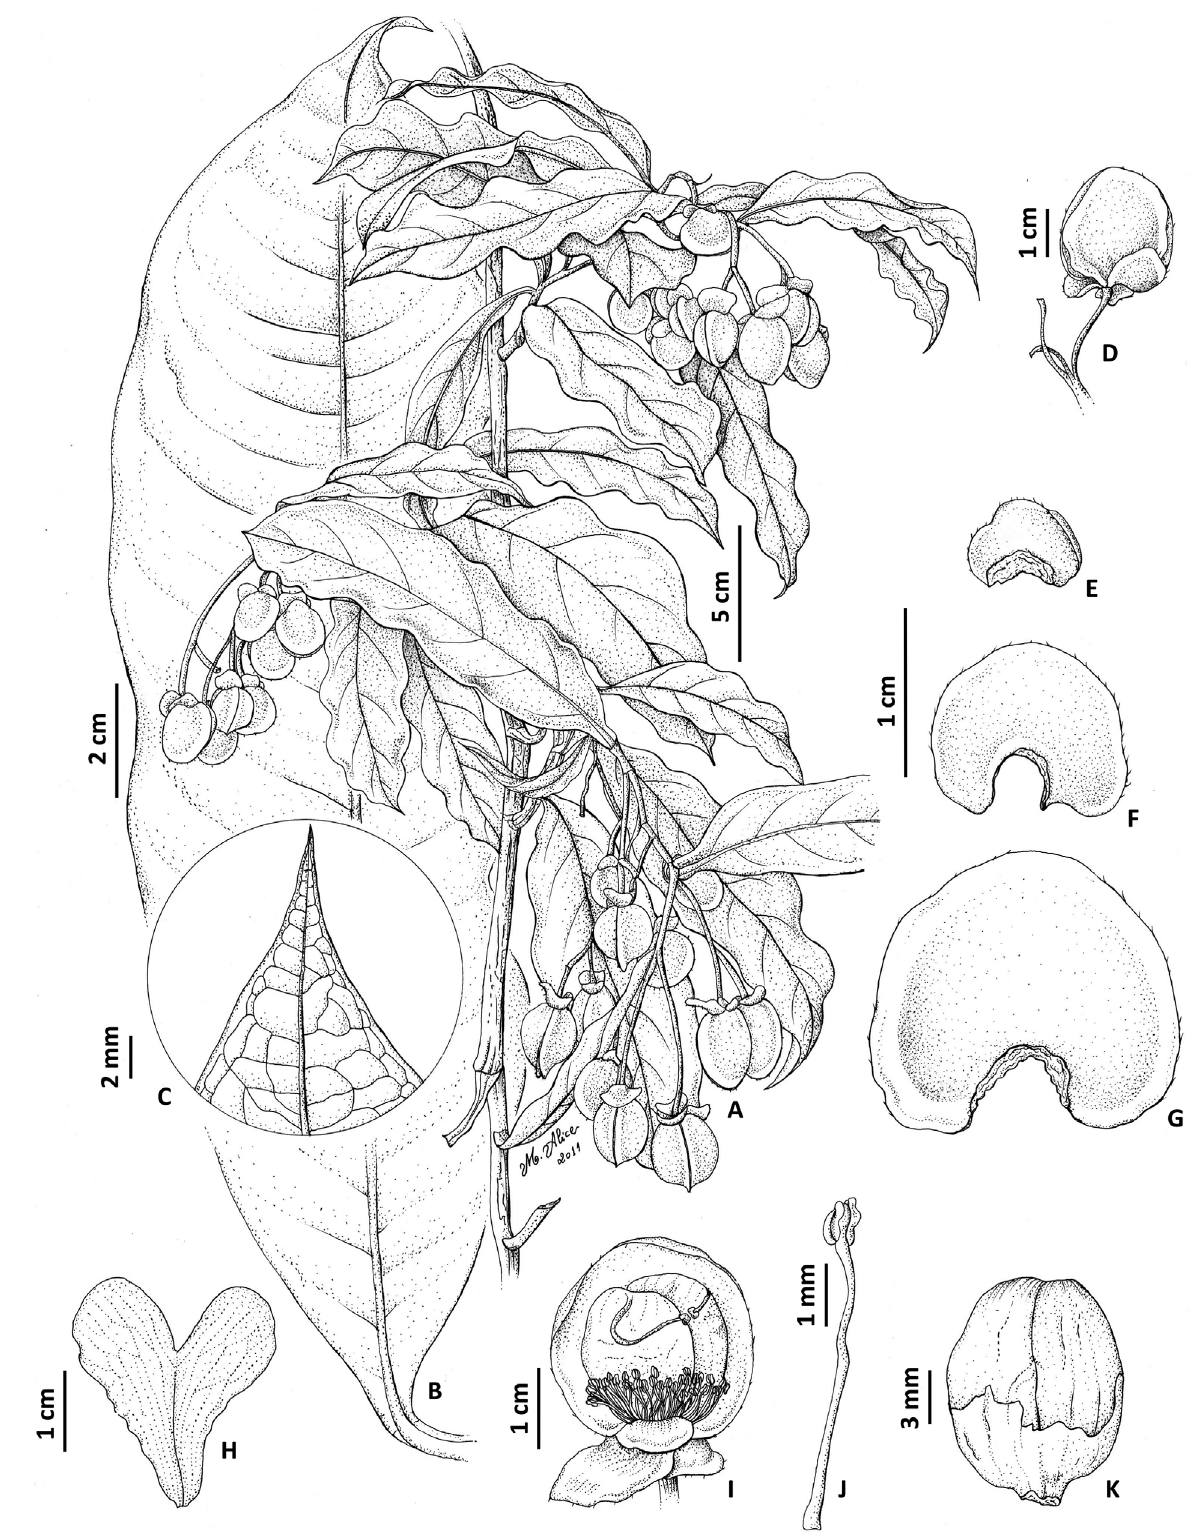
Figure 4 – Davilla undulata Fraga & Stehmann: A, habit; B, adaxial leaf surface; C, leaf apex, abaxial surface; D, flower in lateral view, with persistent sepals covering stamens and ovary; E-G, three external sepals, abaxial surface (external, median, and internal); H, adaxial surface of petal; I, frontal view of persistent sepals covering stamens and ovary, with the other sepal removed; J, stamen in dorsal view; K, two seeds in dorsal view, with aril removed. From Fraga 3268, except H from Hatschbach 48719. Drawn by Maria Alice